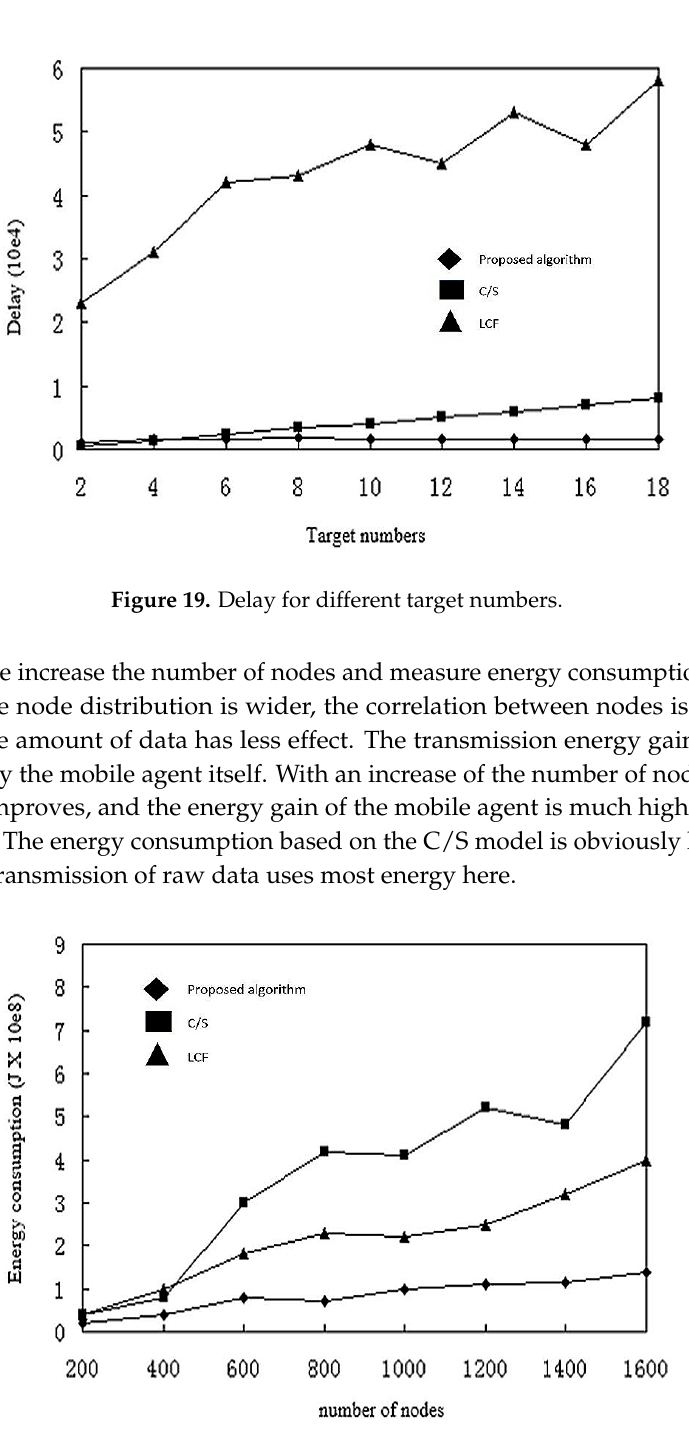
Figure 20. Effect of node density on energy consumption.